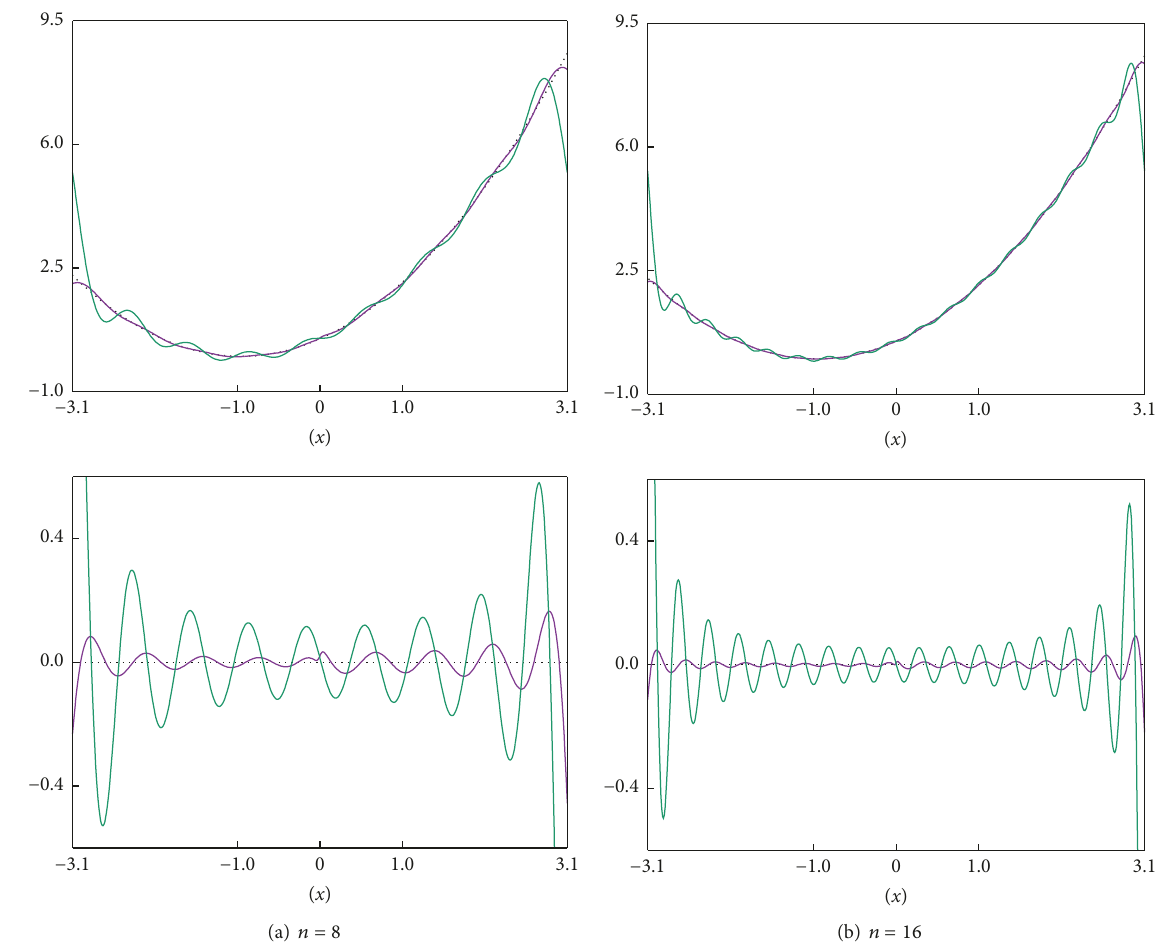
Figure 4: Approximations of the weighted average 𝐹 𝑛 (𝑥) in upper rows and the corresponding errors in lower rows for the test function 𝑓 (𝑥) . Thin lines indicate approximations and errors of the Fourier partial sum 𝑆 2